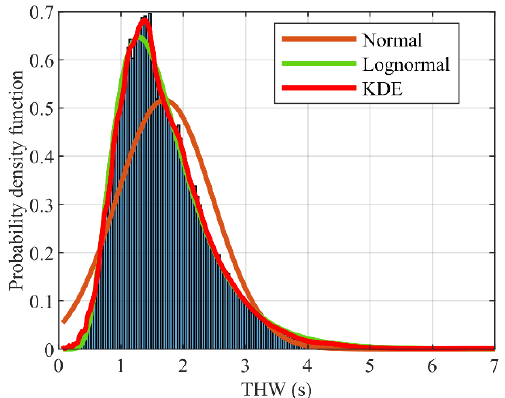
Figure 5. Time headway probability density distribution and fitting curve based on training da- taset.